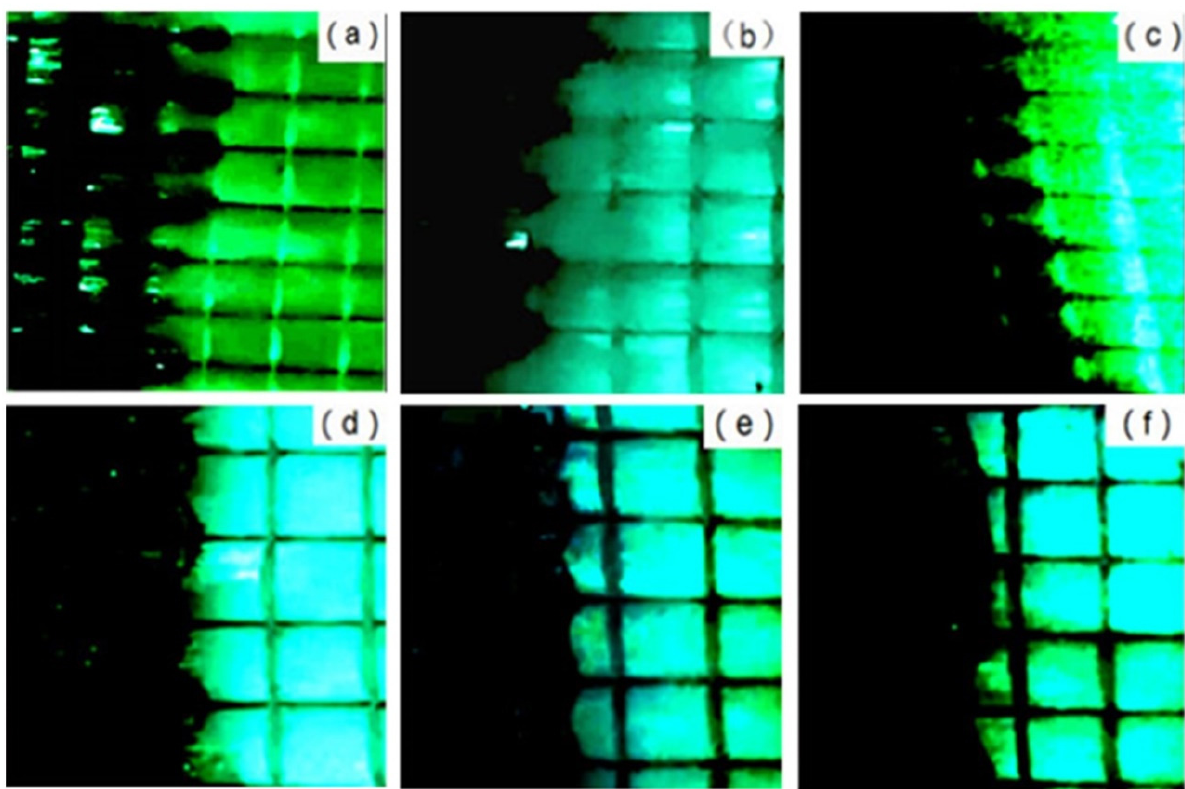
Figure 13. The influence of capillary number on flow front morphology: ( a ) 0.094; ( b ) 0.072; ( c ) 0.058; ( d ) 0.038; ( e ) 0.028; (f) 0.018.